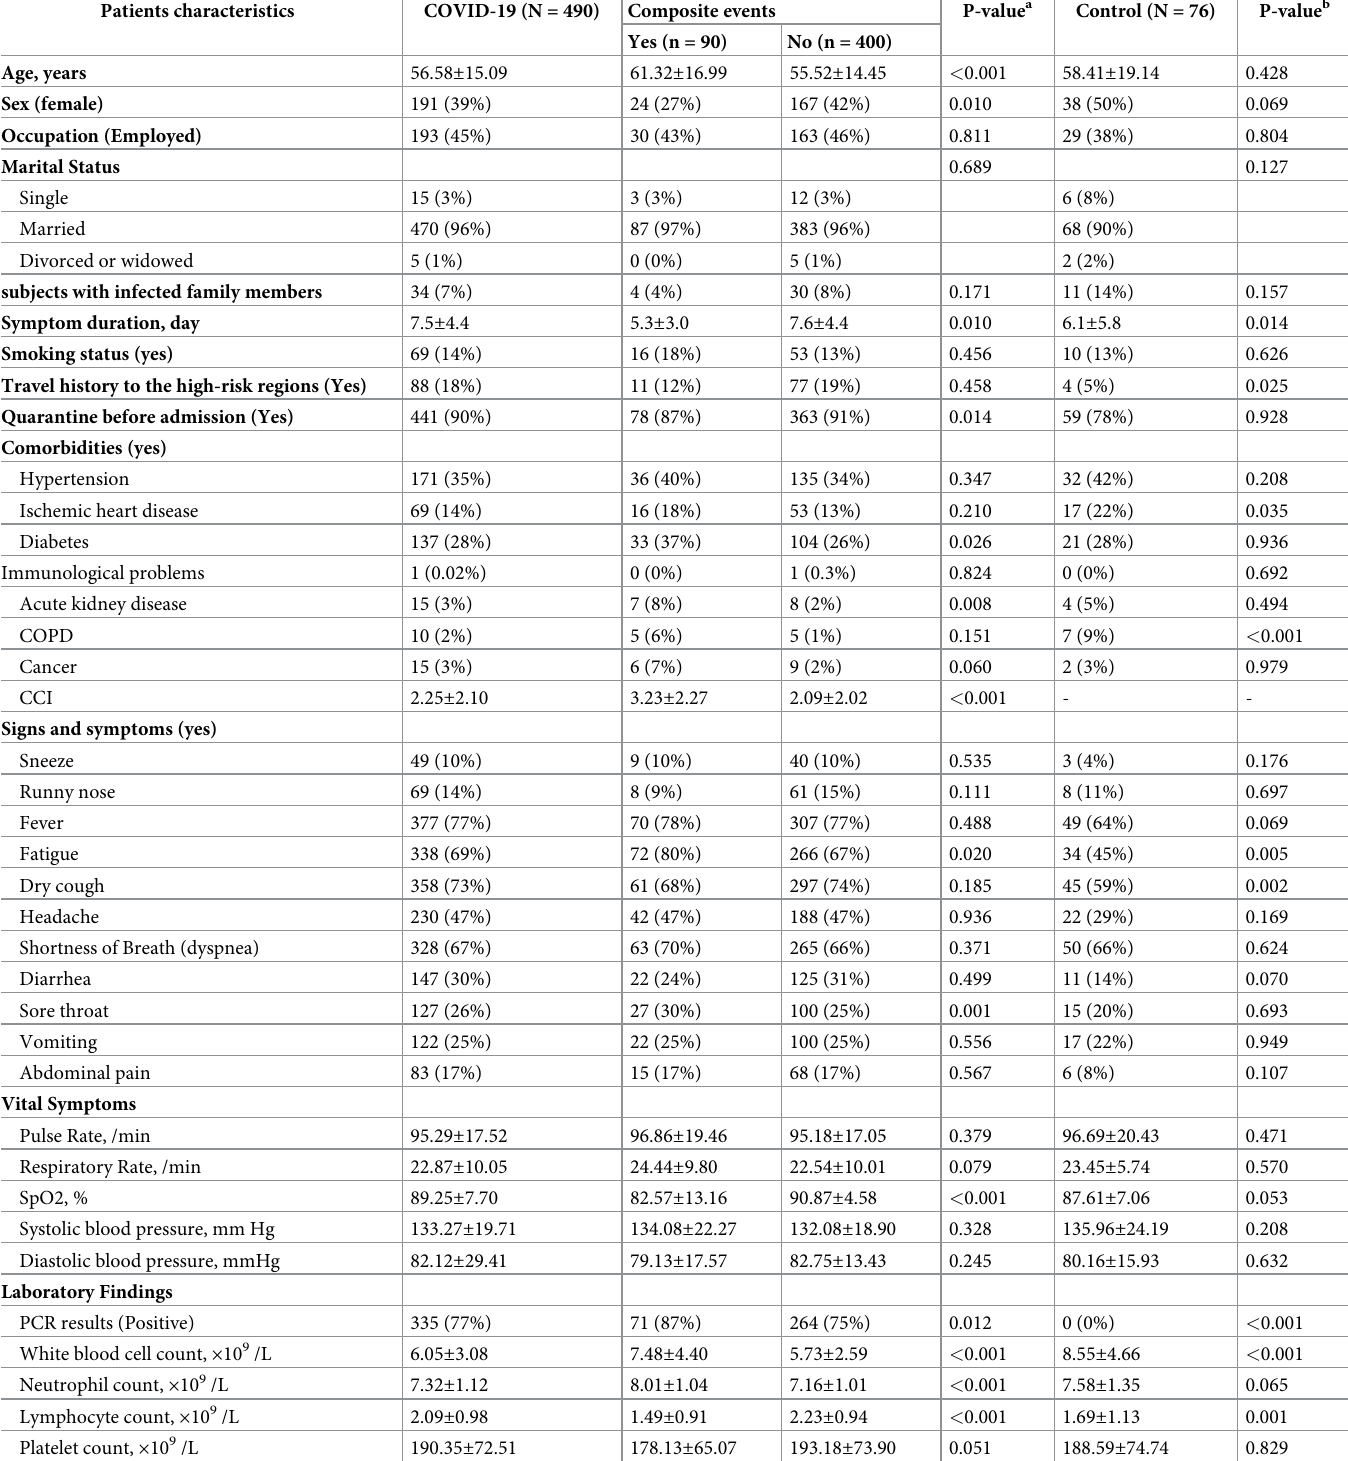
Table 1. Demographic, SES, comorbidities, signs and symptoms, vital symptoms, and laboratory findings of 490 patients admitted to a COVID-19 referral hospital in